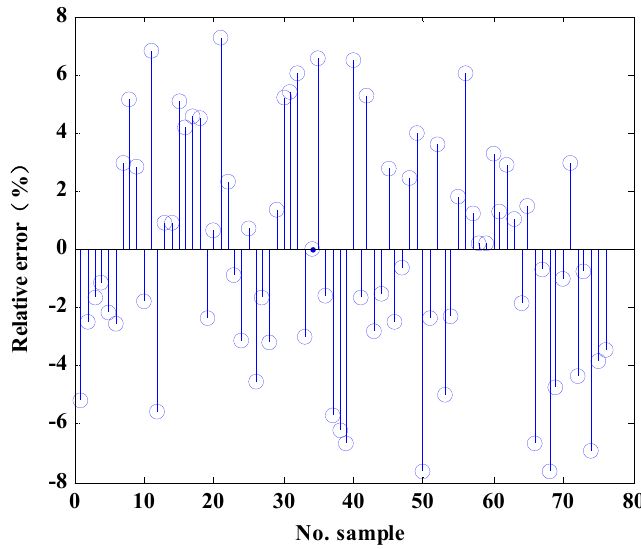
Figure 16. The relative error of the GA-BP ANN model.